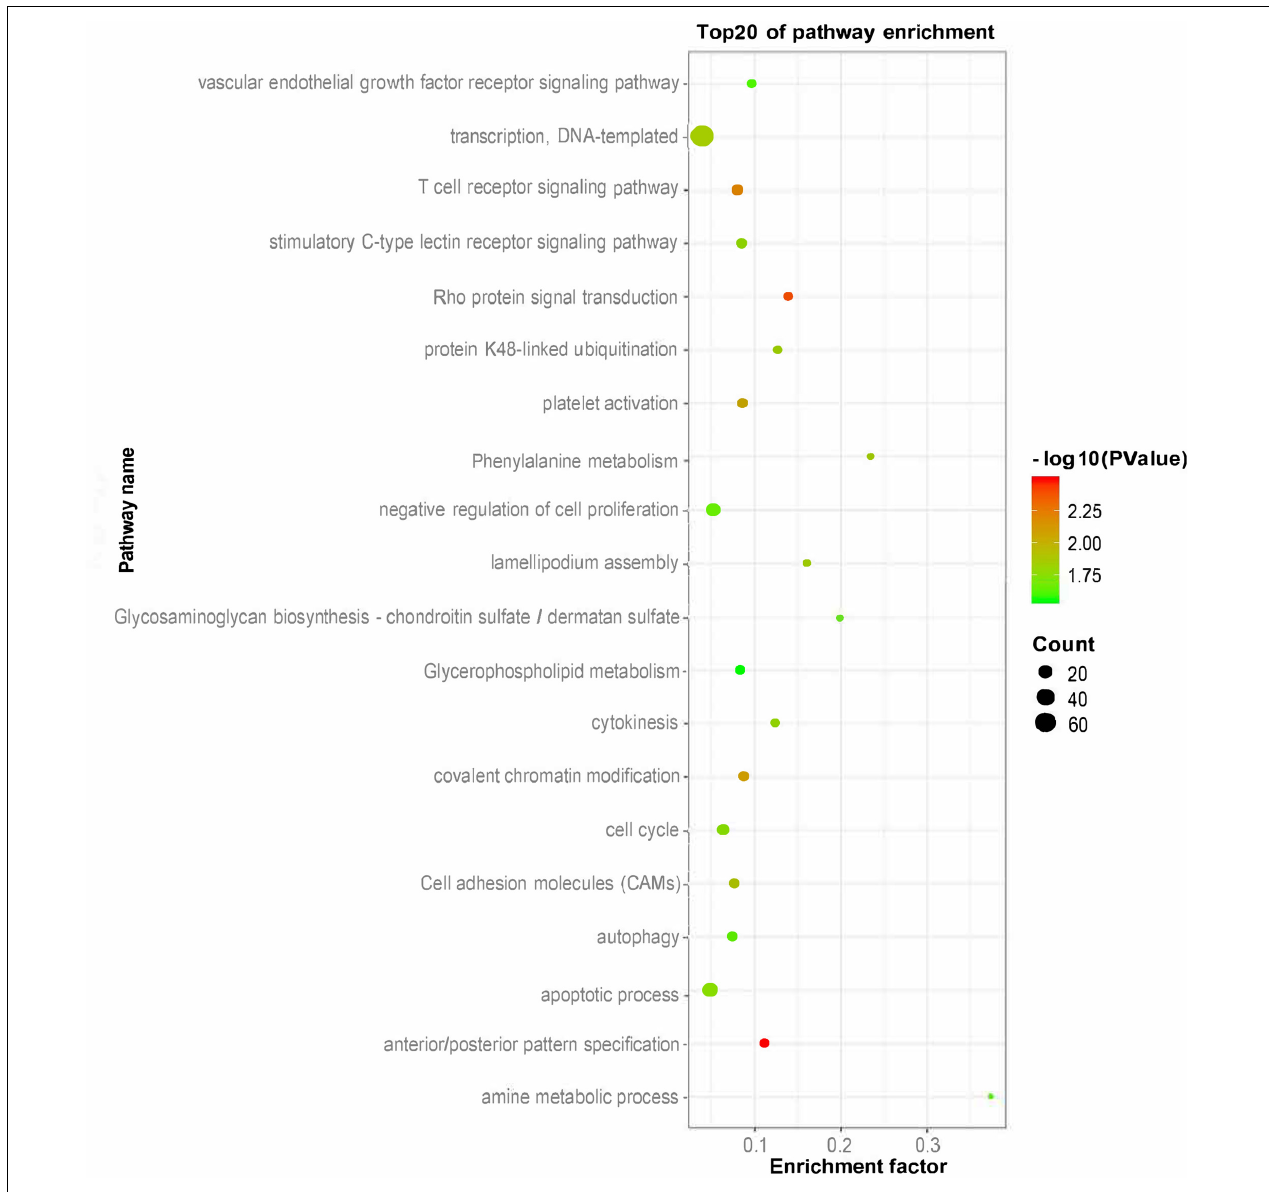
FIGURE 4 | Gene ontology and pathway analysis of adjacent genes of